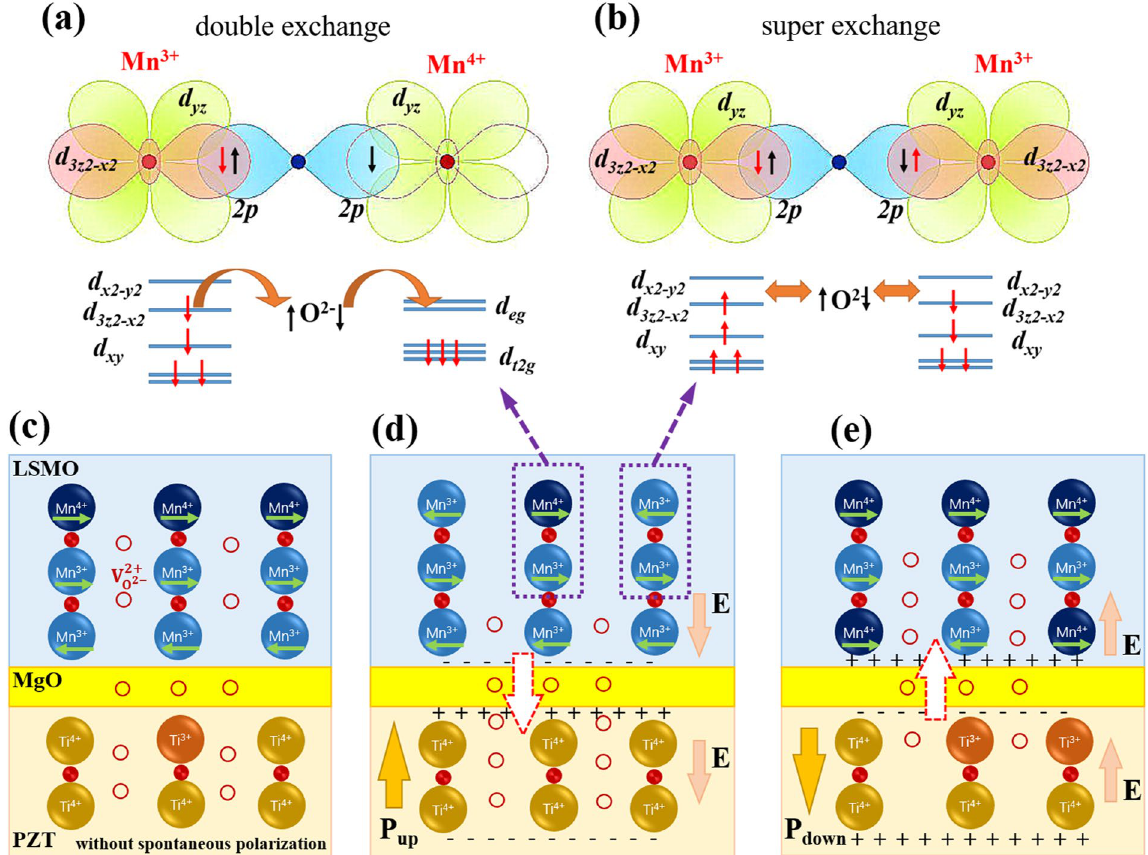
Figure 7. Illustrations of mechanisms of ( a ) double exchange and ( b ) super exchange which lead to the modulation of the change of magnetization, ( c ) motions of oxygen vacancies in the heterostructure without spontaneous polarization, ( d ) upward remnant polarization, and ( e ) downward remnant